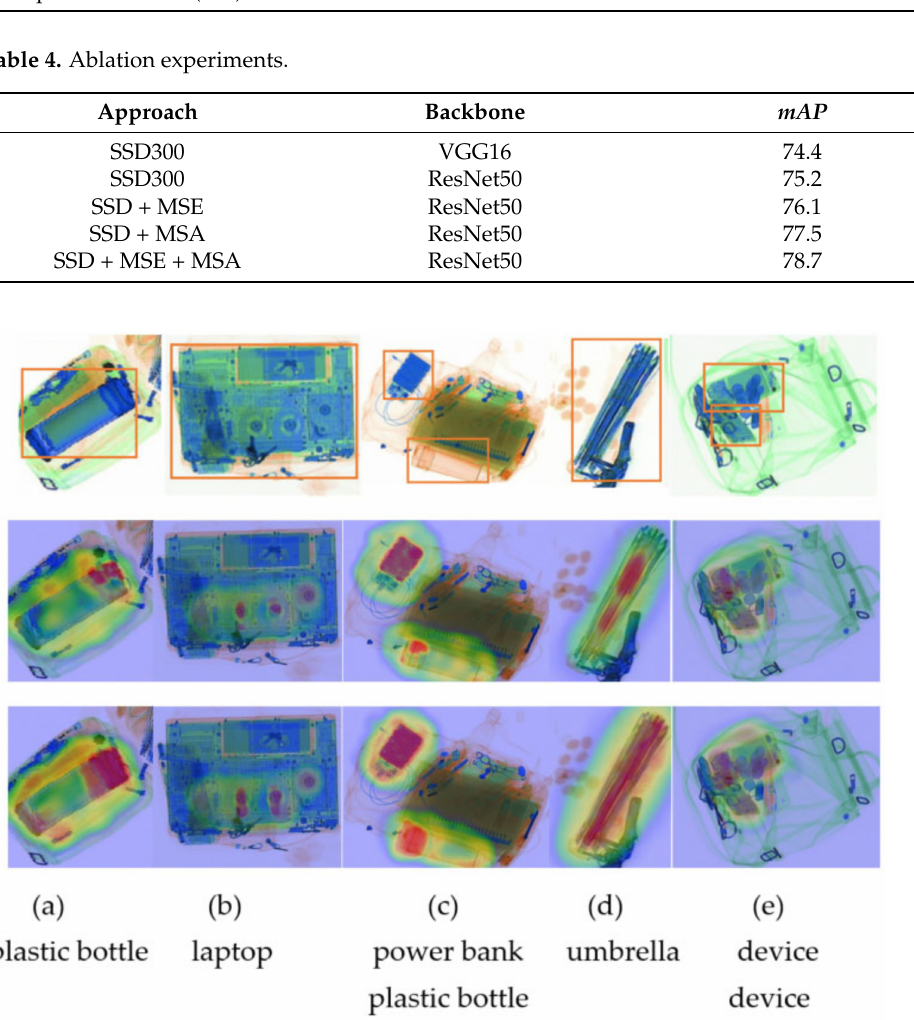
Figure 12. Visualization results of the class activation